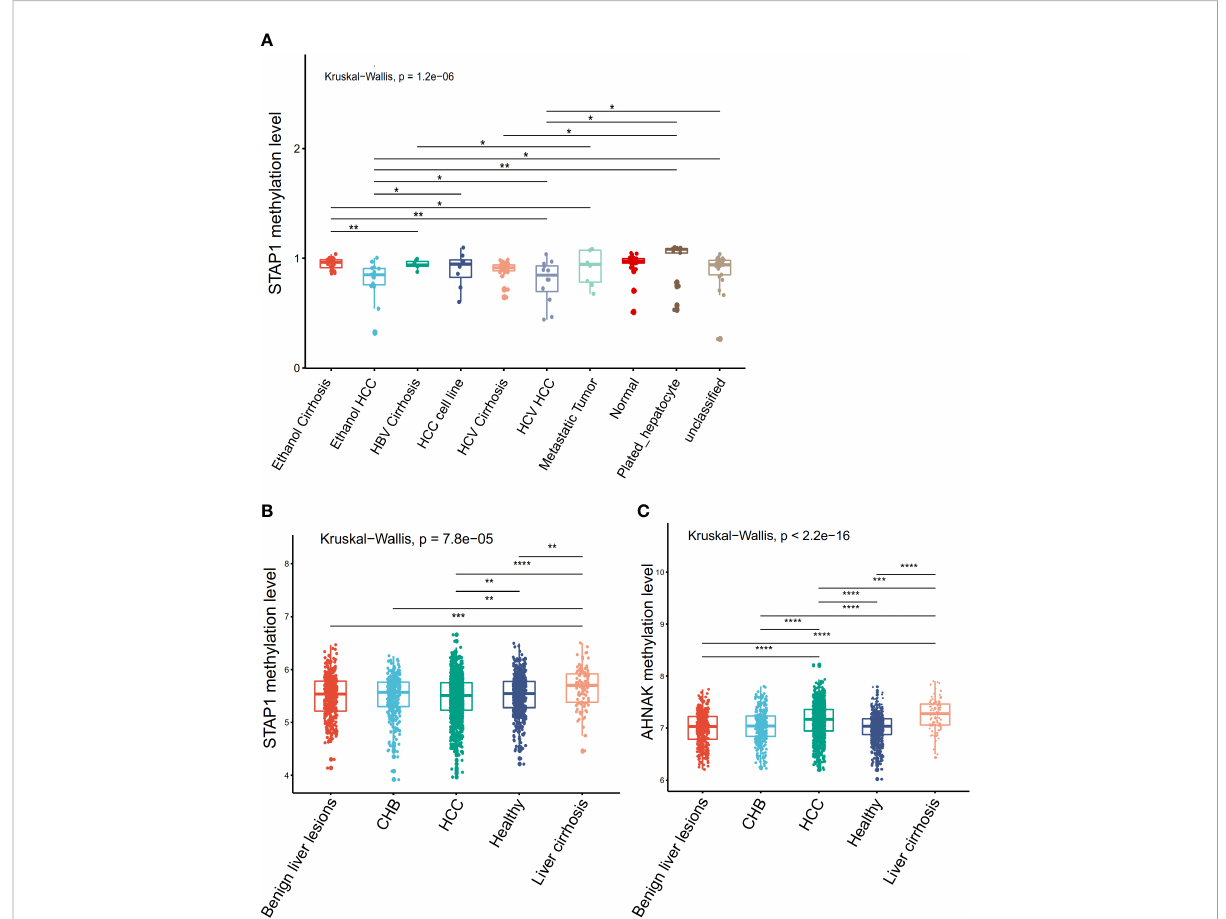
FIGURE 3 Comparison of the methylation of AHNAK and STAP1 among different types of liver disease in the Gene Expression Omnibus datasets. (A) Comparisons in STAP1 methylation among the different types of liver cirrhosis and hepatocellular carcinoma (HCC) patients (GSE60753 data). (B) Comparisons in STAP1 methylation among the chronic hepatitis B (CHB), liver cirrhosis, and HCC patients and benign liver lesions (GSE112679 data). (C) Comparisons in AHNAK methylation among the CHB, liver cirrhosis, and HCC patients and benign liver lesions (GSE112679 data). * P < 0.05, ** P < 0.01, ***p < = 0.001, ****p < =